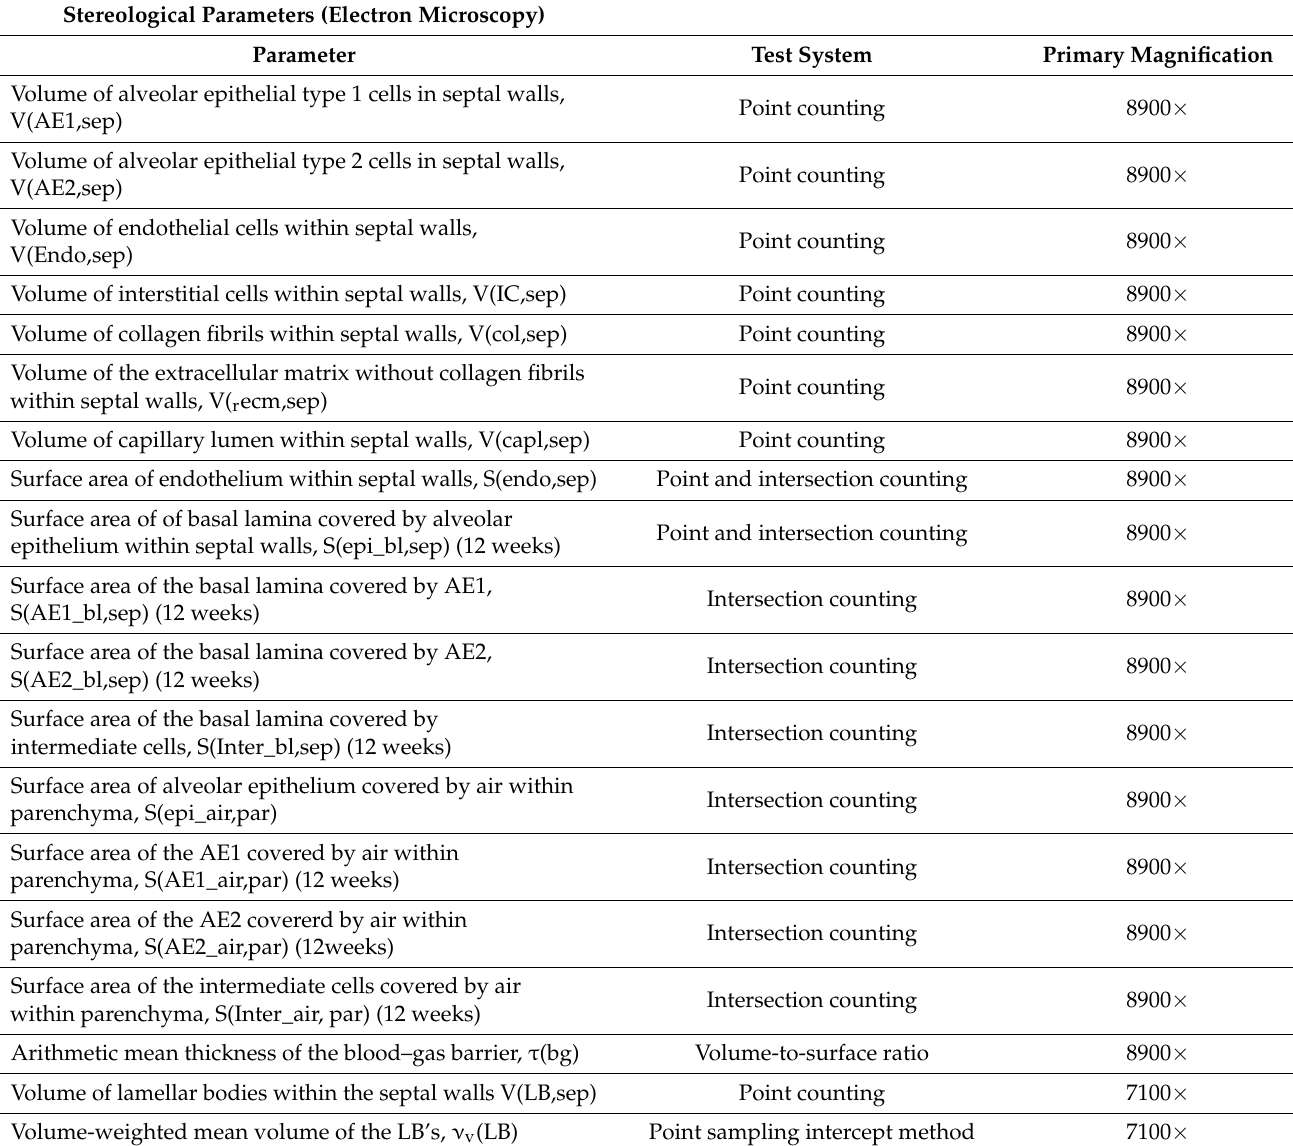
Table 5. Definition of electron microscopic stereological